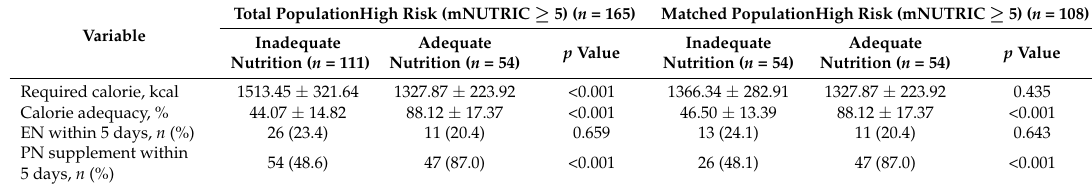
Table 3. Calorie requirement and adequacy of patients with high mNUTRIC